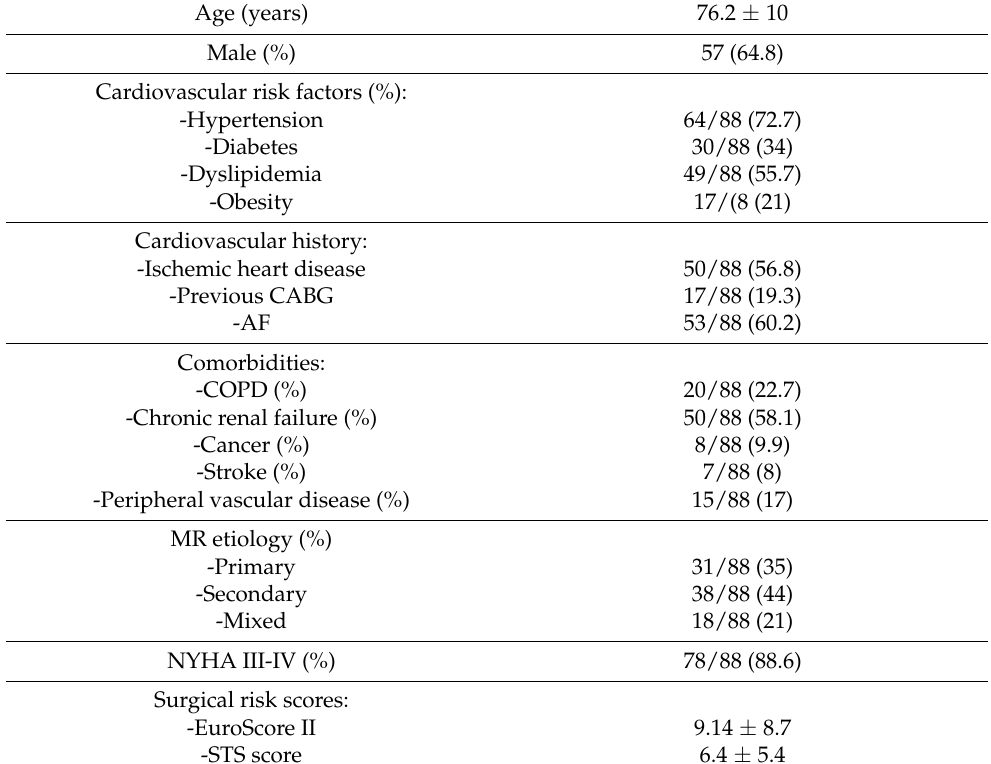
Table 1. Baseline clinical